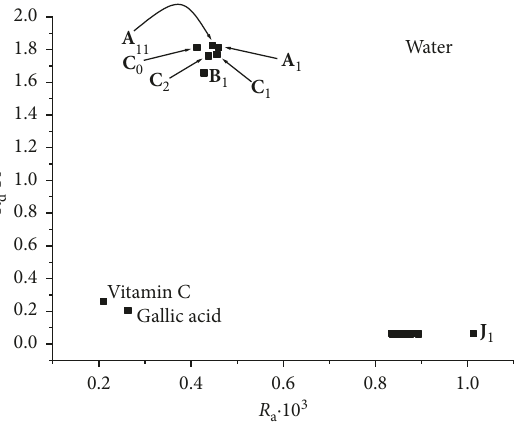
Figure 6: Donor-acceptor maps of anthraquinone derivatives, vitamin C, and gallic acid in water.